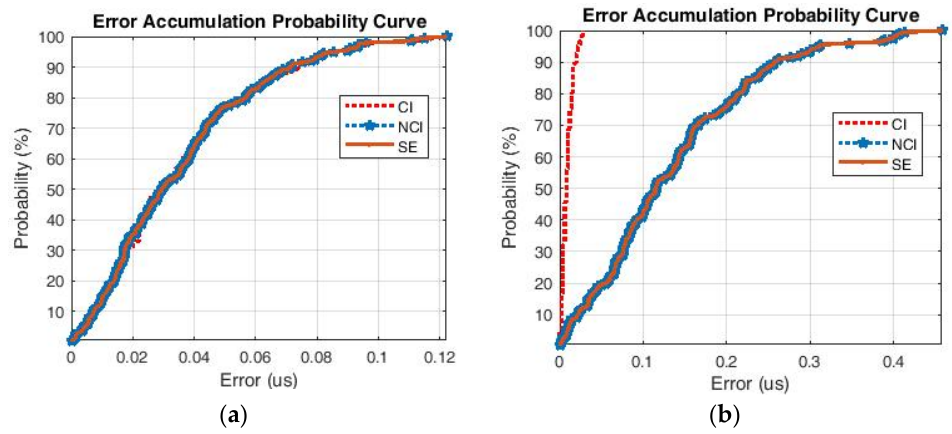
Figure 2. Normalized cross correlation comparison of coherent integration and separate process at SNR = 20 dB. ( a ) Reference signal cross correlation. ( b ) Target signal cross correlation.